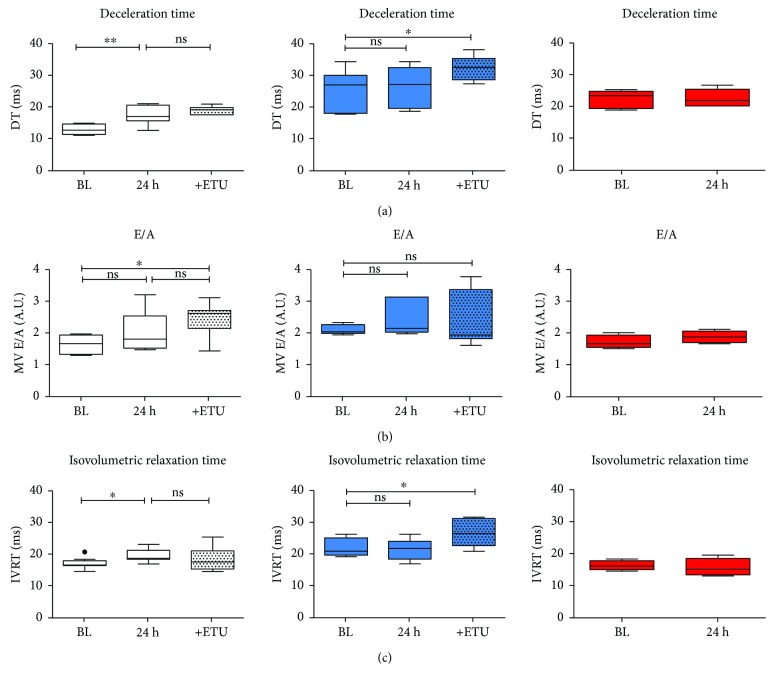
Nrf2 KO mice are protected against impairment of myocardial diastolic function following AMI. (a) I/R injury resulted in an impairment of diastolic function (evaluated with prolonged deceleration time (DT)), (b) E/A relation, and (c) relaxation time (IVRT) in WT mice (white box plots), whereas preexisting diastolic dysfunction was not aggravated in Nrf2 KO mice (blue box plots). In eNOS KO mice (A, red box plots), diastolic dysfunction evidenced by increased DT as compared to WT mice (Supplementary Table 1) was not further exacerbated after AMI. WT mice: n = 9, Nrf2 KO mice: n = 8; Browne-Forsythe test p > 0.05, means ± quartiles, one-way ANOVA ∗
p < 0.05, ∗∗
p < 0.01 except for eNOS KO mice n = 4‐5, unpaired t-test.